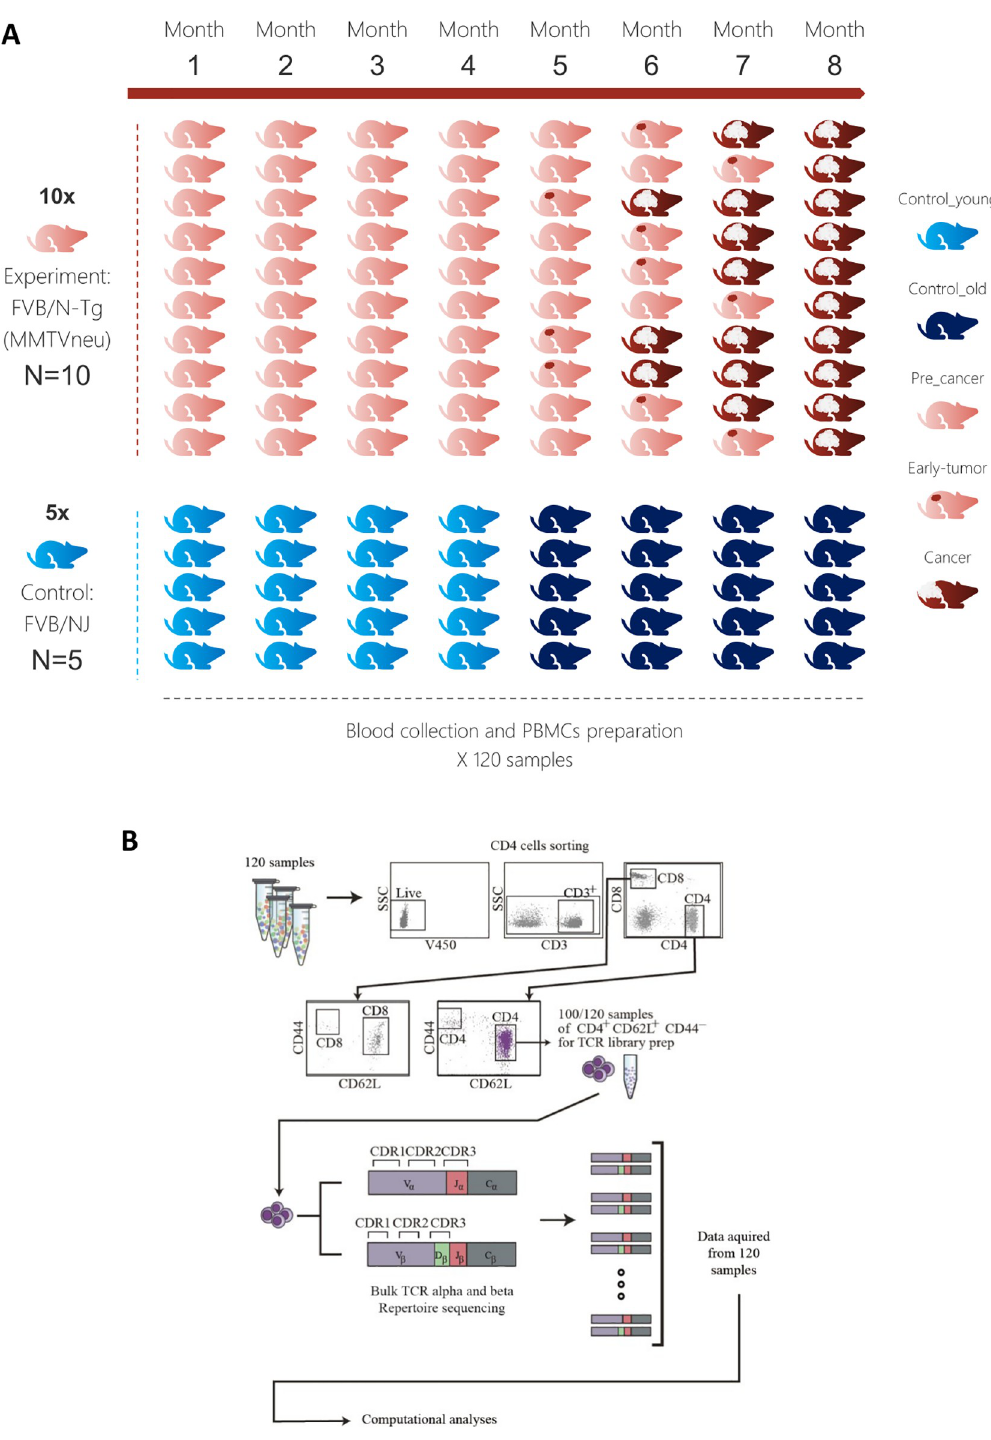
Fig 1. Experimental procedure. (A) 120 blood samples were drawn from the retro-orbital sinus of 10 FVB/N-Tg (MMTVneu), a mouse model of HER2 human breast cancer mice, and from 5 FVB/NJ Control mice. Over these 8 time- points, none of the Control mice (blue) developed any tumors. We will use the term "Transgenic" for FVB/N-Tg(MMTVneu) 202 Mul/J and "Control" for FVB/NJ strain. Progress of tumor in the ten Transgenic mice is demonstrated using the red colored samples in the figure. The last time point before tumors are shown was defined as pre-cancer and marked light red. (B) At each time point, the peripheral blood mononuclear cells were isolated and stained for flow cytometry. Cells were analyzed and gated for sorting using a FACS ARIA III sorter, and the CD4 + CD62L hi CD44 lo na ï ve population was